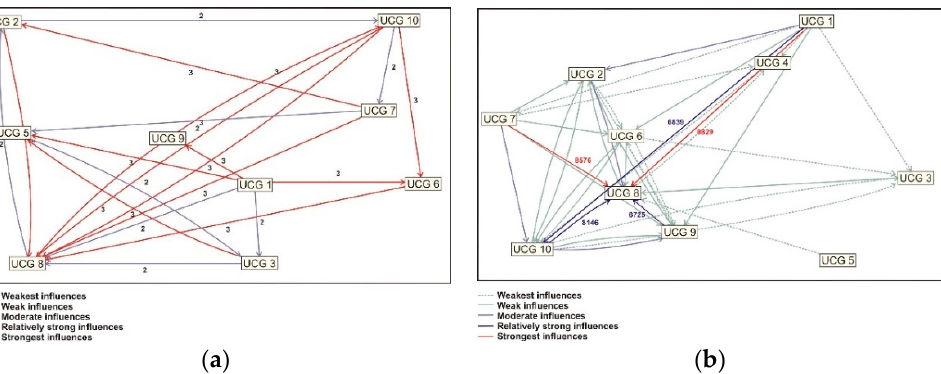
Figure 8. Graphs of structural analysis: ( a ) direct influences/dependences for UCG criterion; ( b ) indirect influences/dependences for UCG criterion.